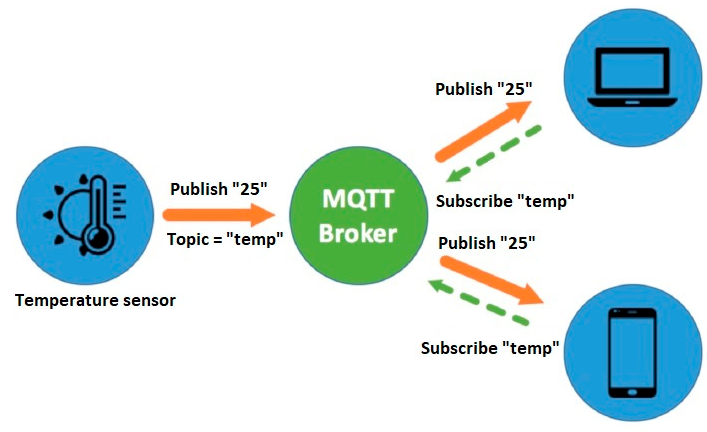
Figure 2. MQTT Figure 2. MQTT architecture.